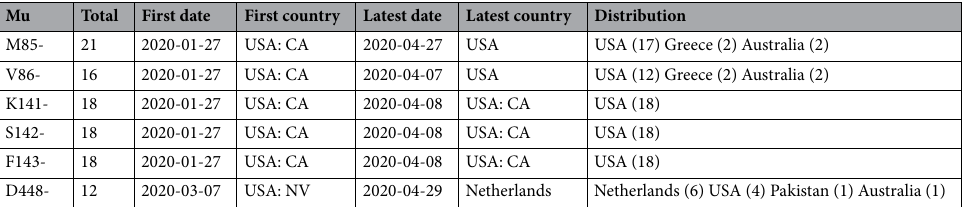
Table 2. Gene ORF1ab—deletion mutations occurring in 10 or more sequences.